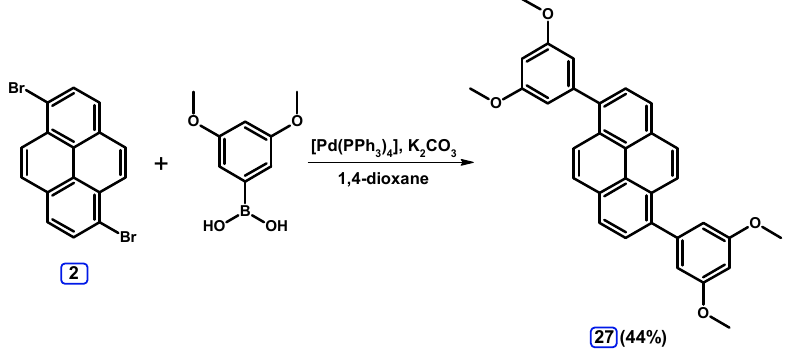
Scheme 14. Suzuki-Miyaura coupling reaction resulted in molecule 27